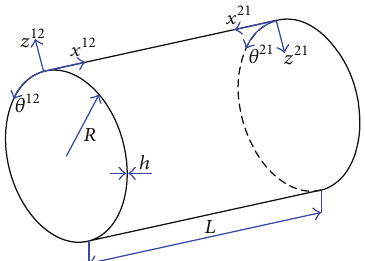
Figure 1: Geometry and the dual local coordinate system for a circular cylindrical